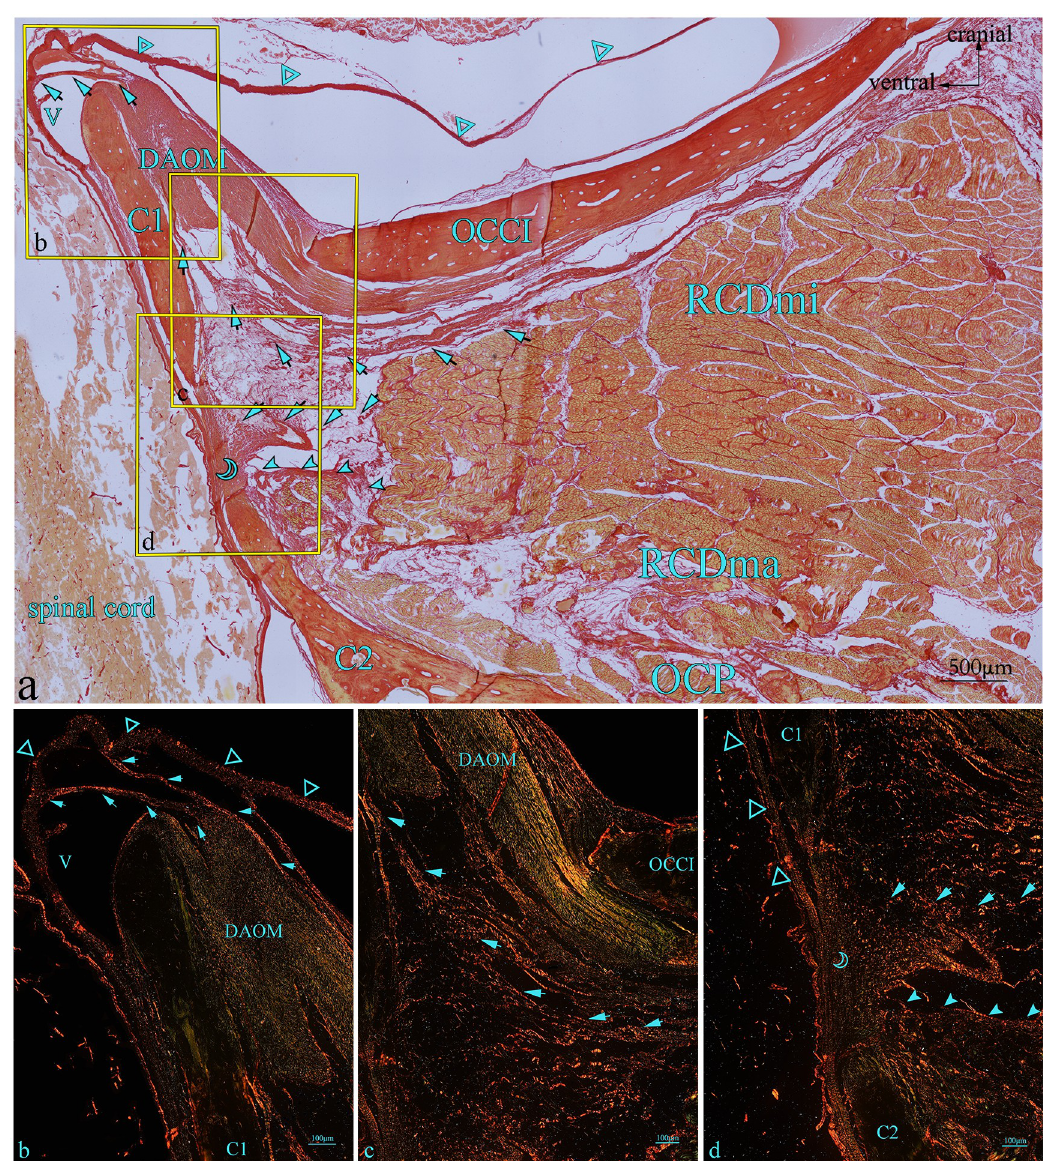
Fig 5. Gentoo penguin, prepared sagittal section of the suboccipital region with stained with PSR-stained. Area within square in a is shown enlarged in b, c and d. The fibers (arrow) originate from the ventral anterior of RCDmi, extend directly into the atlanto-occipital interspace, then fuse with the DAOM, and the DAOM extends into a fiber bundle through the venous sinus to connect with the SDM (hollow triangle). In the atlanto-axial interspace, the dense fibers bundles (arrow) originating from the ventral side of the RCDmi run ventrally, and integrate into the dorsal atlanto-axial membrane (hollow crescent) together with the dense fibers(filled arrowhead) originating from the RCDma and OCP, and send out dense fibers bundles to closely connect with the SDM. Abbreviation: OCCI = occipital bone; RCDmi = rectus capitis dorsalis minor muscle; OCP = oblique capitis posterior; DAOM = dorsal atlanto-occipital membrane; SDM = spinal dura mater; C1 = atlas; C2 = axial; V = venous sinus. and the OCP, all converging to form the MDB, and then passing through the dorsal atlanto- axial membrane, which is tightly connected to the SDM. The arrangement of the fibers of the MDB, observed in the Gentoo penguin is similar to that of other birds [25, 26] and mammals [20]. Although penguins live in different conditions from that of the Rock pigeons and the